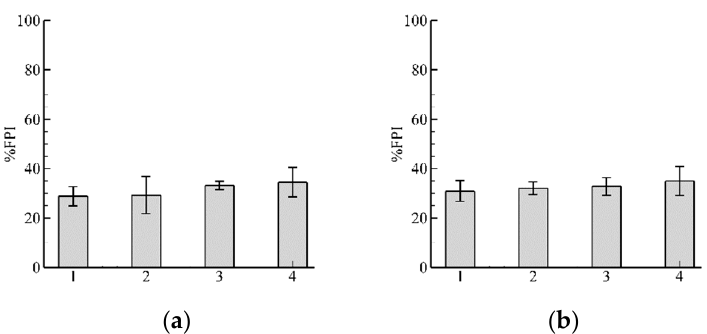
Figure 8. Results of fish passage index %FPI for 𝐶 (cid:3045)(cid:2868) = 3.0 and two different 𝑛 (cid:3045)(cid:2868) closest to fish position nodes: ( a ) 𝑛 (cid:3045)(cid:2868) = 10 and ( b ) 𝑛 (cid:3045)(cid:2868) = 50 . It is clearly seen that the mean values of %FPI do not